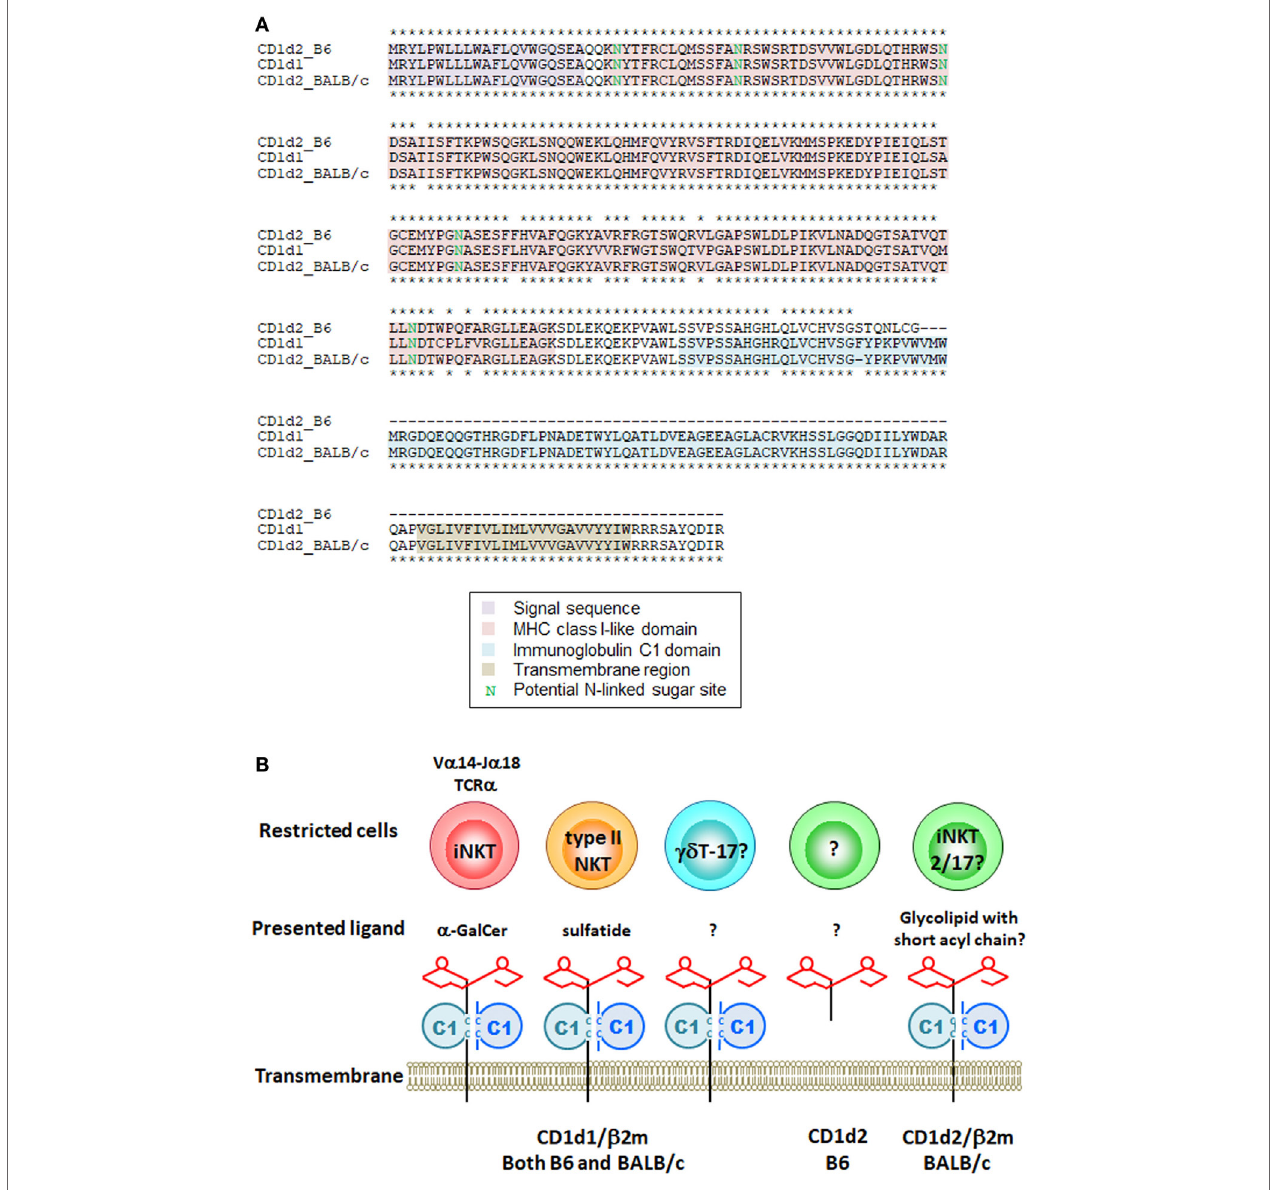
FiGURe 1 | Mouse CD1d molecules and their restricted cells. (A) Amino acid sequences of mouse CD1d1 and CD1d2 from B6 and BALB/c mice were aligned by ClustalW. Asterisks indicate identical amino acids between CD1d2 from B6 vs CD1d1 (upper) and CD1d2 from BALB/c vs CD1d1 (lower). (B) Schematic representation of mouse CD1d molecules, presented ligands and their restricted cells. The CD1d1 molecule restricts different cells depending on the presented antigen(s). The structure of CD1d2 is different among species in mice due to the frameshift mutation. The CD1d2 molecule in B6 mice has MHC class I-like domain required for the presentation of glycolipid ligand(s) but lacks immunoglobulin C1 domain. It is still unclear whether the soluble form of CD1d2 works as an antigen presenting